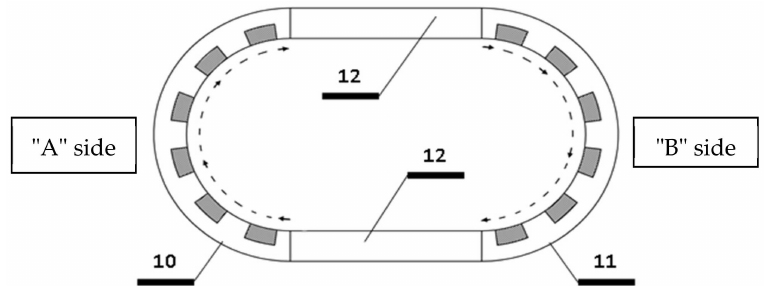
Figure 6. Front view of an arched inductor without demonstrating the coil heads. The inductor is of a closed magnetic circuit constructed by connecting the magnetic circuit of the “half” inductor pair (by closing the magnetic circuit) using ferromagnetic bridges